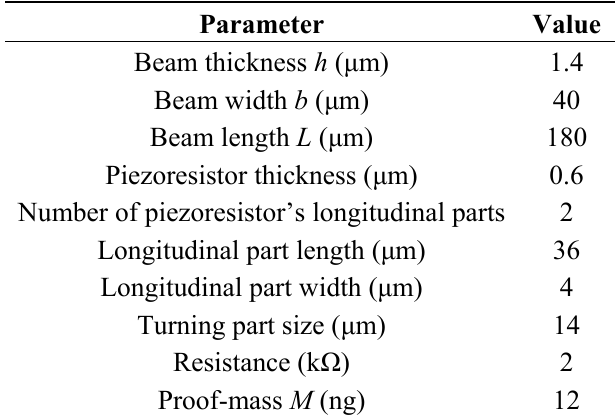
Table 2. Structure parameters of the designed piezoresistive